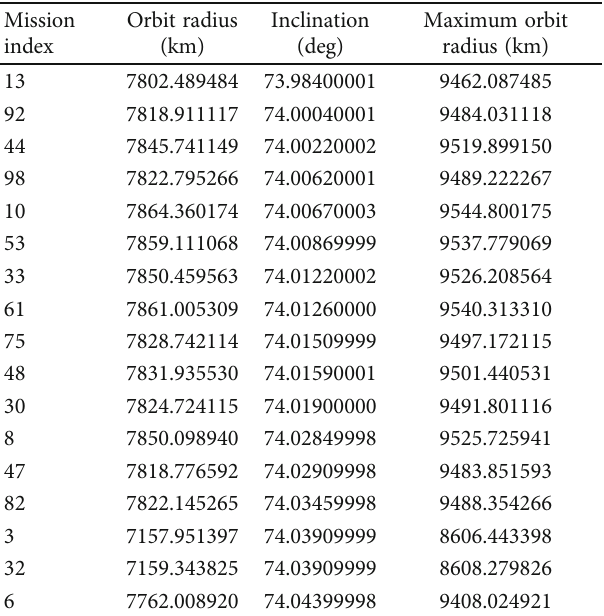
Table 2: Maximum orbit radius estimations of the piggyback launches that are inclined at angles of approximately 74 °